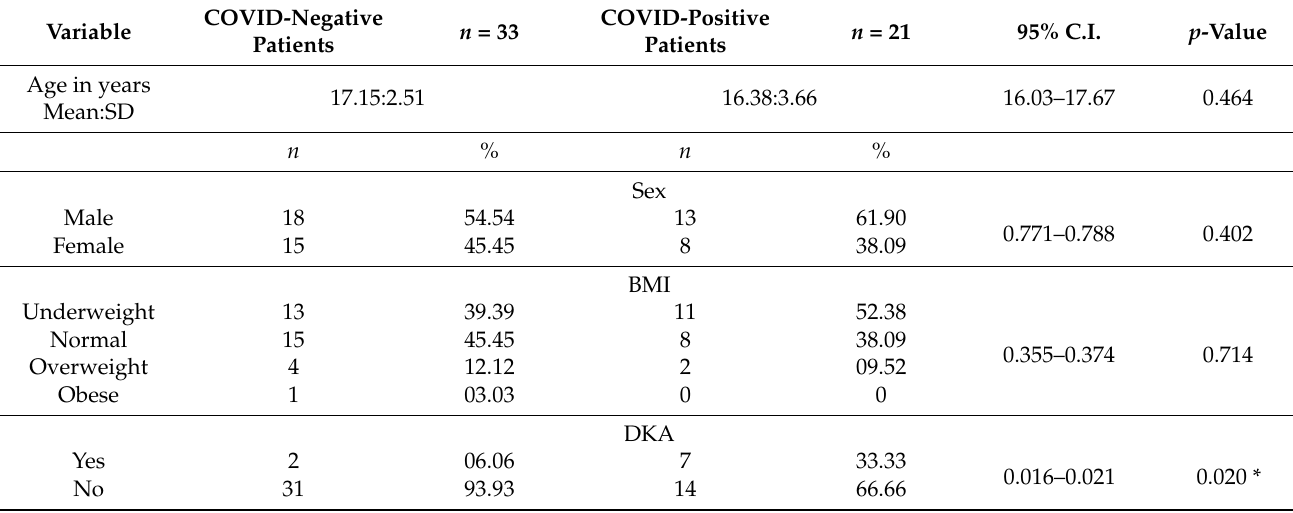
Table 2. Bivariate analysis according to COVID-19 status.